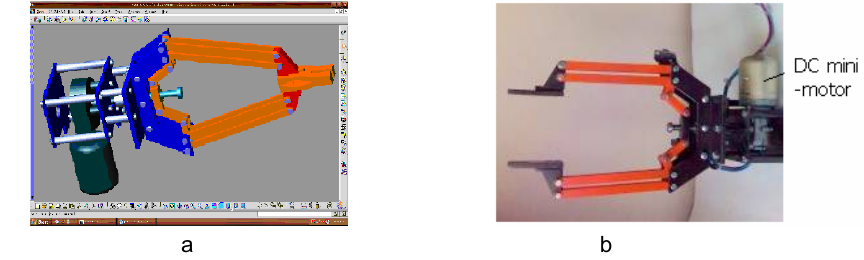
Figure 9 – CATIA project of the gripper (a) and prototype of the gripper (b) Slika 9 – Projekat hvataljke pomo ć u softvera CATIA (a) i prototip hvataljke